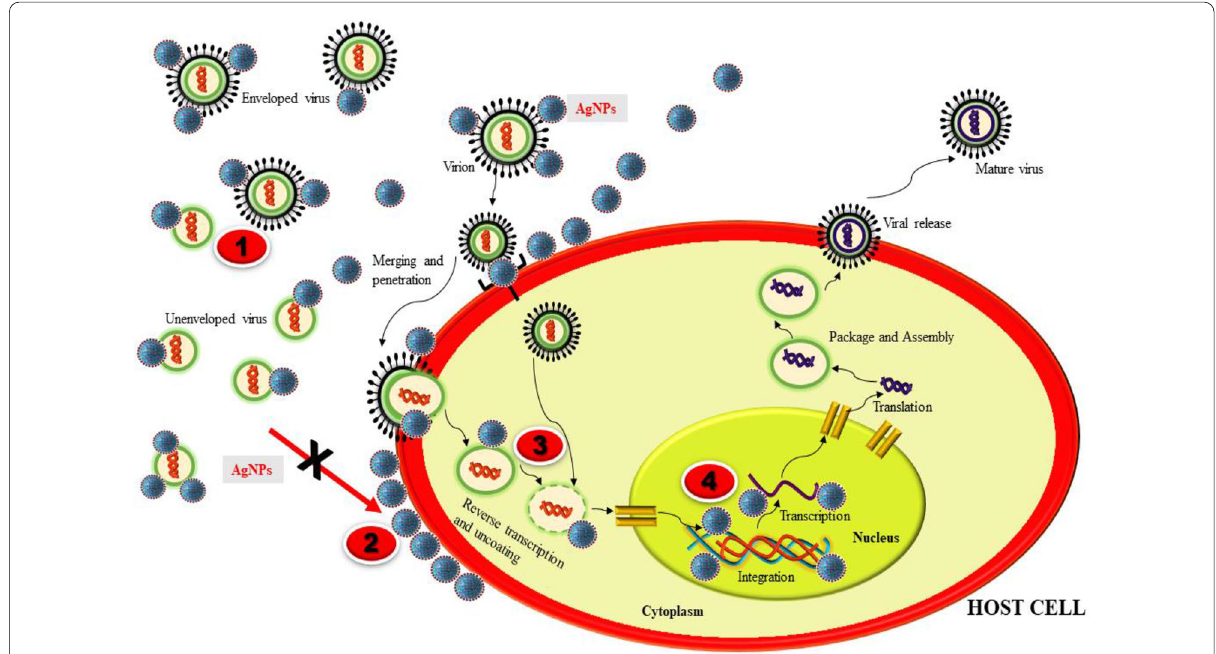
Fig. 4 (1) AgNPs interact with the viral surface protein (gp120) in enveloped and unenveloped virus. (2) AgNPs blocks the penetration of virus into the host cell. (3) AgNPs blocks the cellular viral entry to Nucleus. (4) AgNPs inhibits the viral replication by blocking viral